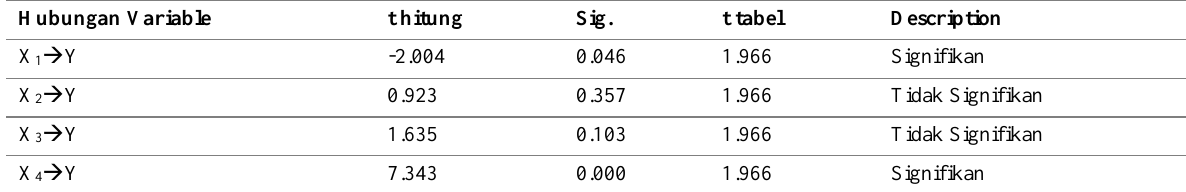
Table 10: t / Partial Test